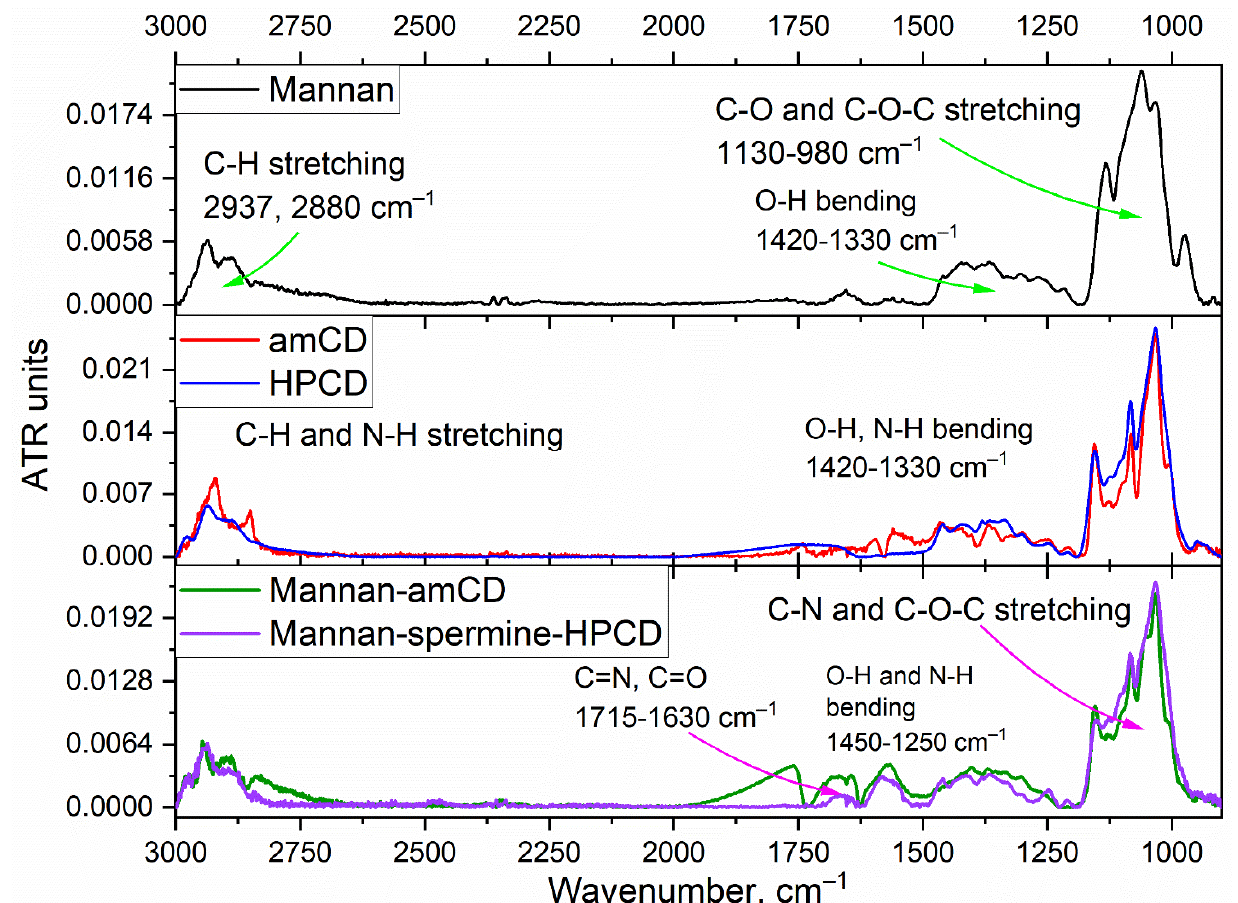
Figure 1. Scheme of synthesis of ( a ) mannan-amCD and mannan-spermine-HPCD, ( b ) FITC-labeled HPCD-PEI1.8 with grafted Man or Gal or triMan, ( c ) FITC-labeled star-shaped HPCD-spermine with grafted Man or Gal or triMan.